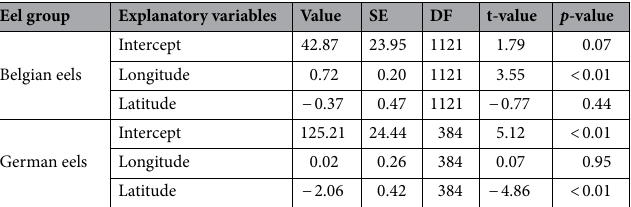
Table 2. The output of the linear mixed effects models for the Belgian and German eels with the estimated value for the intercept and covariates, the standard error (SE), degrees of freedom (DF), t-value and p